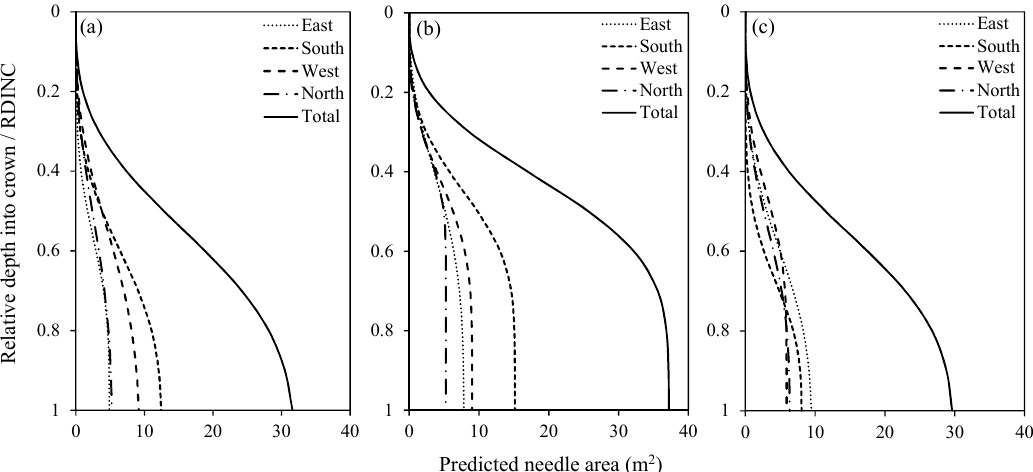
Figure 5. Cumulative vertical distribution of the predicted NA, according to the relative depth into the crown (RDINC) at intervals of 0.1, in different directions for three sample trees: ( a ) tree 1; ( b ) tree 2 and ( c ) tree 3.